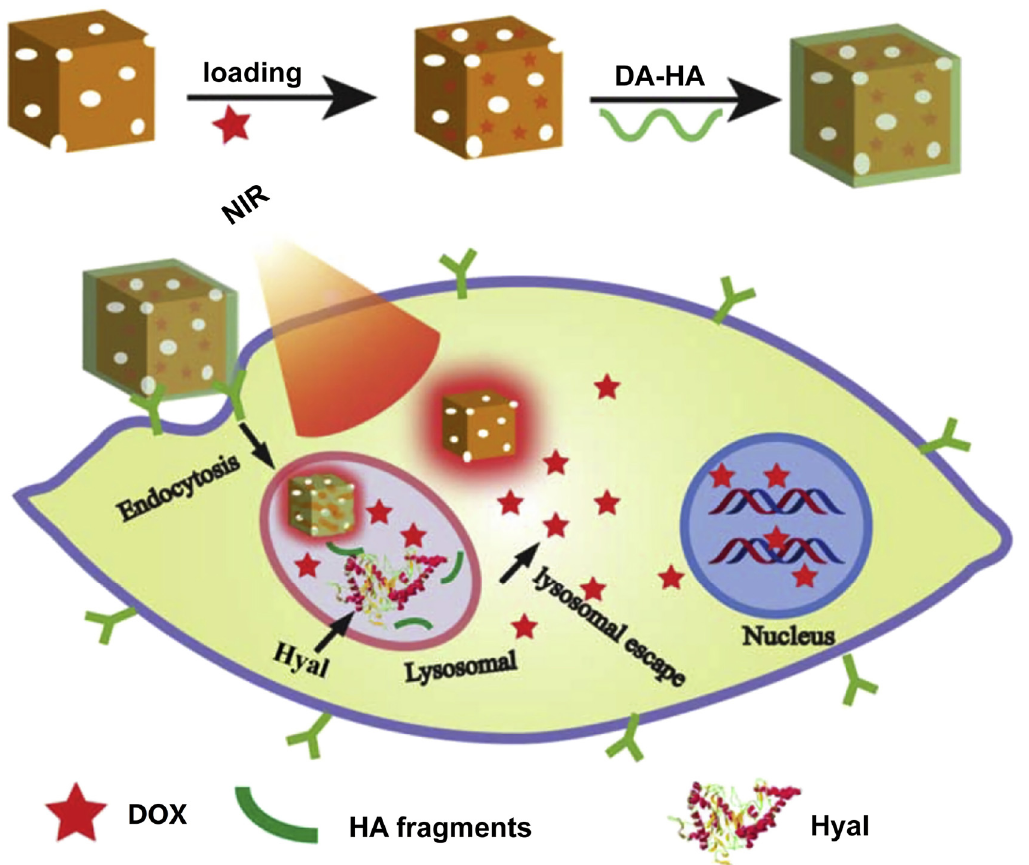
Figure 14. Schematic illustration of a multi-stimuli-responsive nanoplatform based on AuNCs-HA loaded with DOX to precisely control intracellular drug release and synergistic therapy. Reprinted/adapted with permission from Ref. [105]. Copyright 2014, Elsevier Ltd.